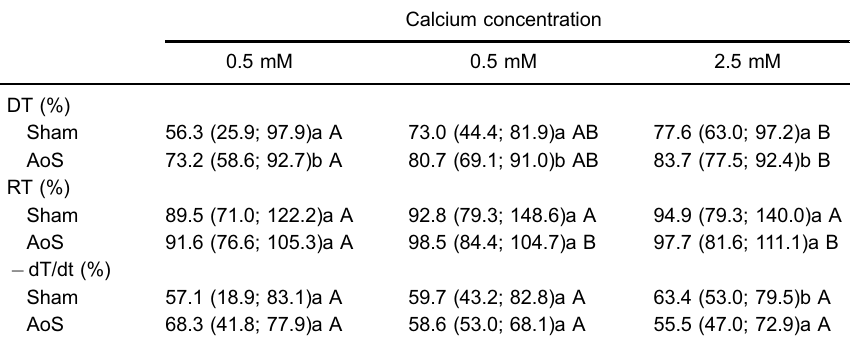
Data are reported as median, minimum and maximum values, regarding basal condition, in percentage (%). Sham: control group, submitted to surgery without clip placement, n=15; AoS: aortic stenosis group, submitted to surgery with clip placement, n=11; DT: developed tension; RT: resting tension; (cid:3) dT/dt: maximum relaxation speed. Lower-case letters: comparison between groups within a calcium concentration; Upper-case letters: comparison between calcium concentrations within a group. P o 0.05 vs Sham (ANOVA, complemented by Student-Newman-Keuls multiple comparisons